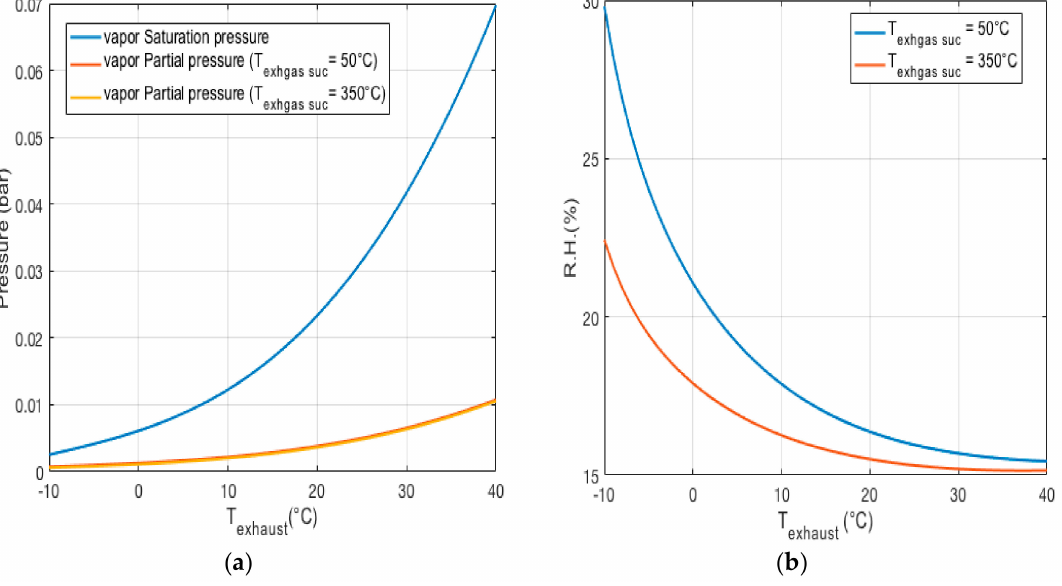
Figure 8. ( a ) Vapor partial pressure and vapor saturation pressure vs. temperature of the discharge ejector. ( b ) Humidity vs. temperature in the mix